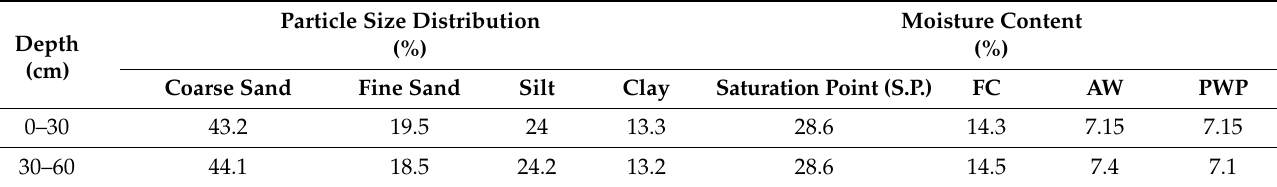
Table 1. Some physical properties of the soil for Bilbeis experimental